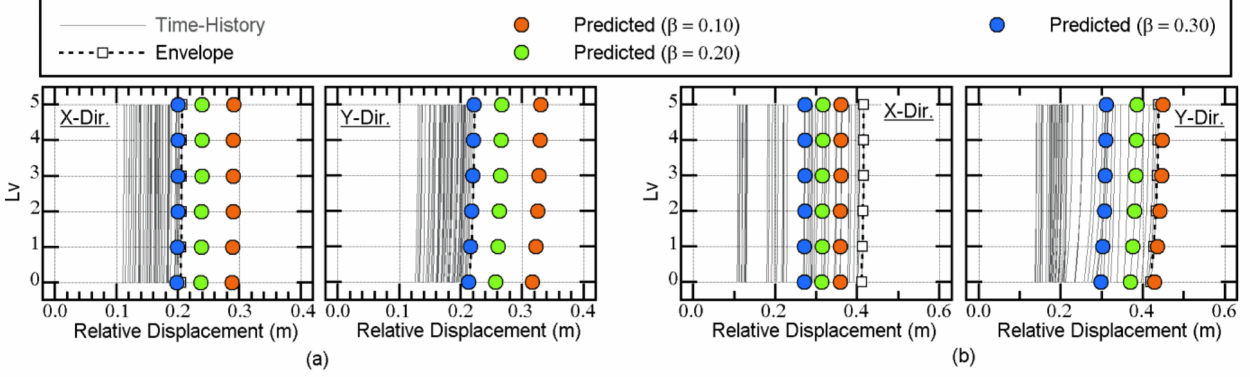
Figure 21. Comparison of the peak relative displacements at X 3A Y 3 (Model-Tf44) for the ( a ) Art-1 and ( b ) Art-2